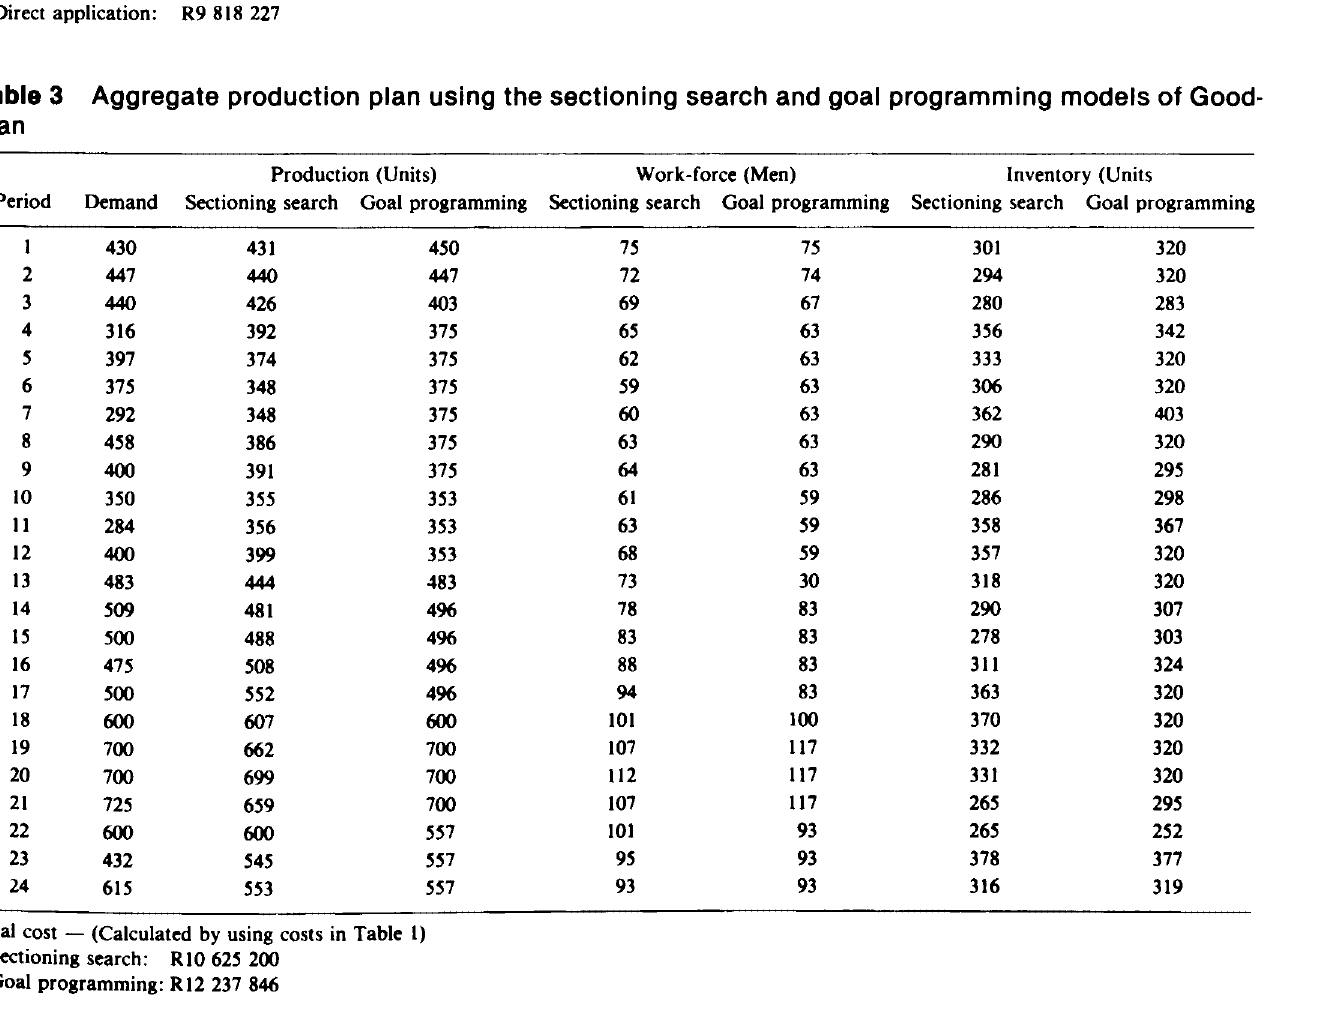
Total cost - (Calculated by using costs in Table I) Sectioning search: RIO 625 200 Goal programming: R12 237